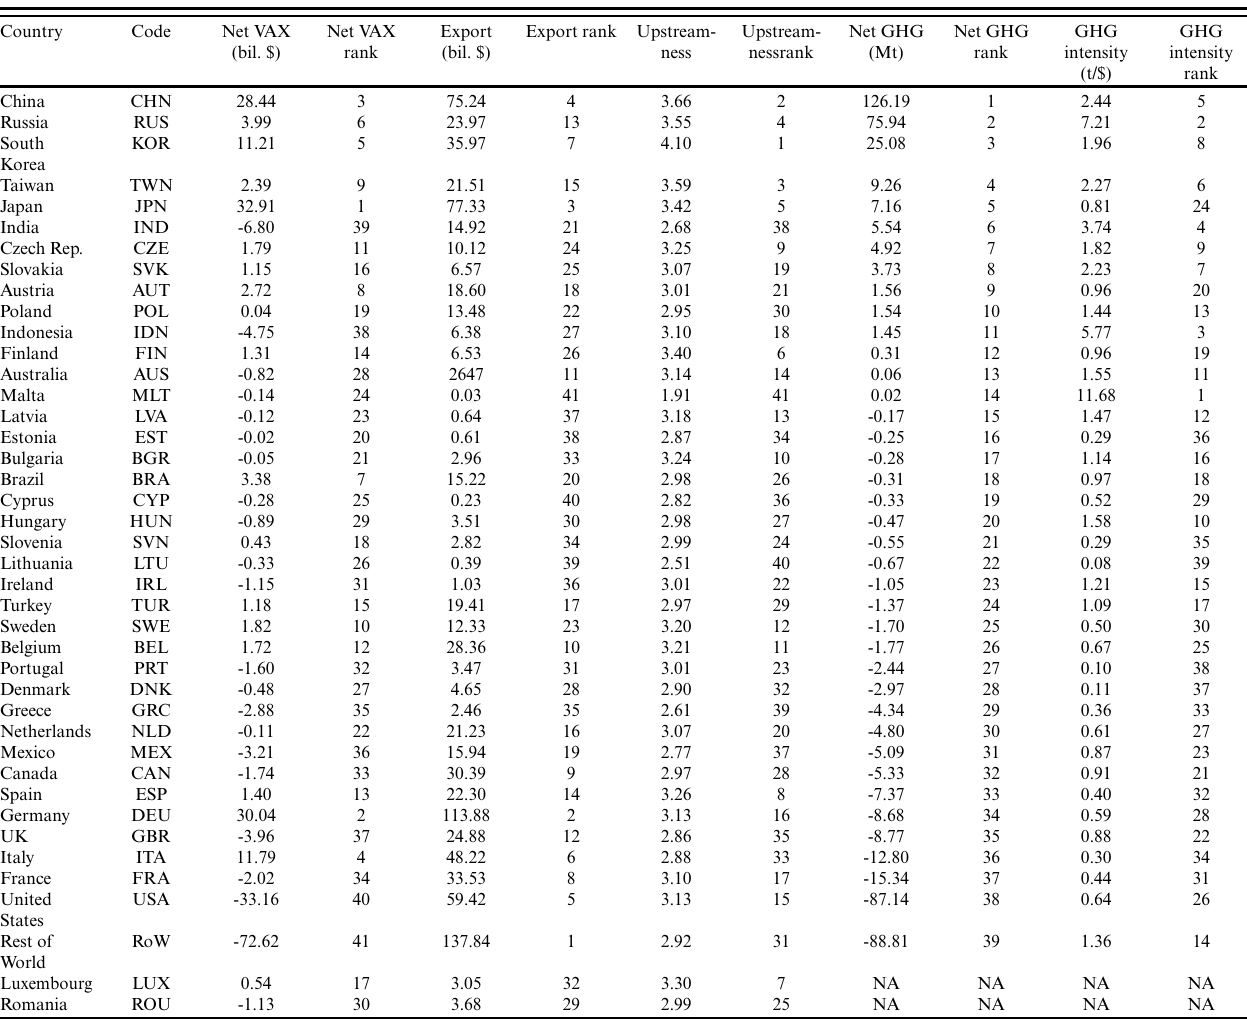
Table 1 . Net flows of value added export (net VAX), gross export (Export), upstreamness (from Antràs et al. 2012), net flows of embedded greenhouse gas (GHG) emissions (net GHG), and GHG emissions intensity (GHG intensity) by country. For net VAX and net GHG, positive values indicate net export and negative values indicate net import. For ranks, 1 is the greatest value. All $ values are